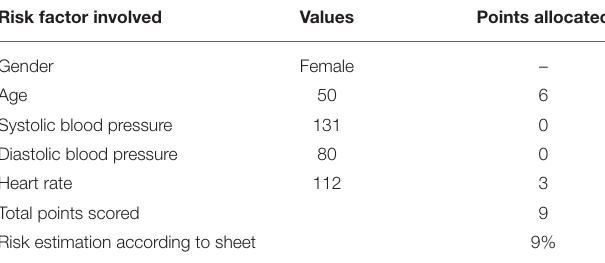
TABLE 14 | Risk point